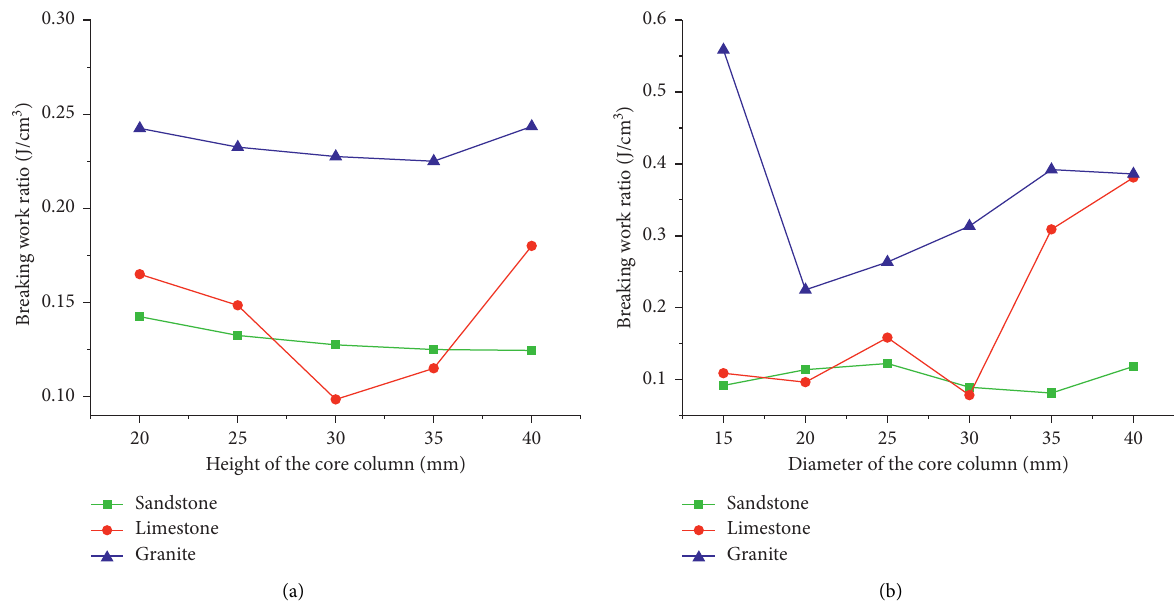
Figure 10: Effects of the breaking work ratio on the size of core columns in the static-pressure experiment.